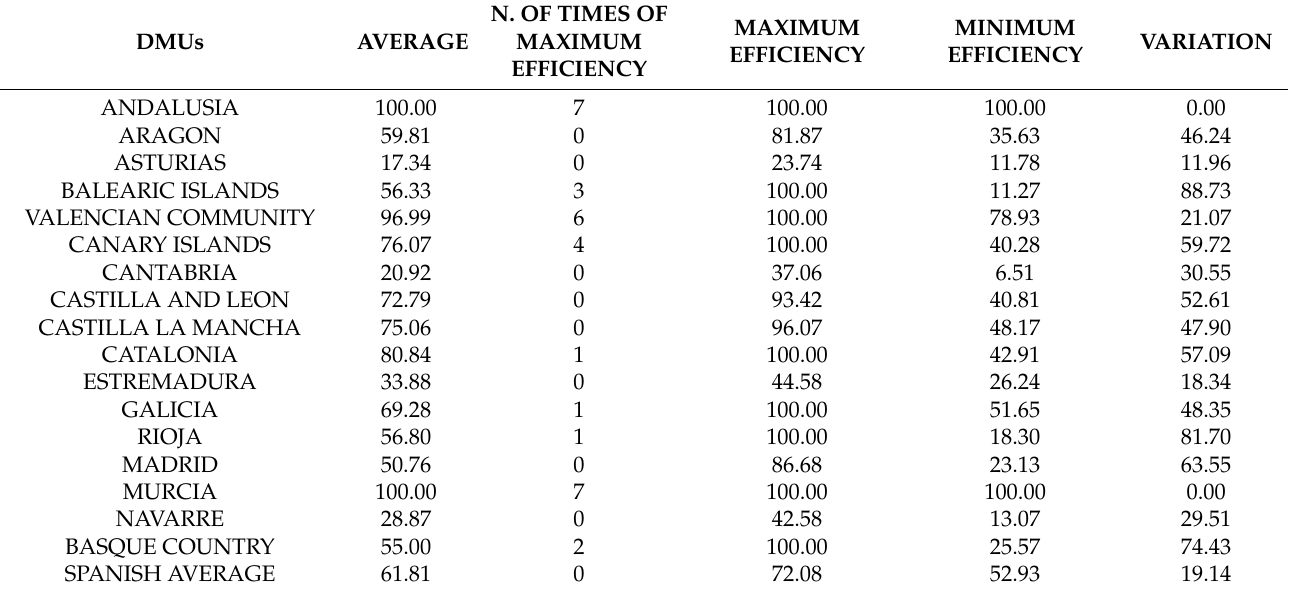
Table 7. Summary of efficiency indicators for the period of 2007–2013 (Source: Own elaboration).